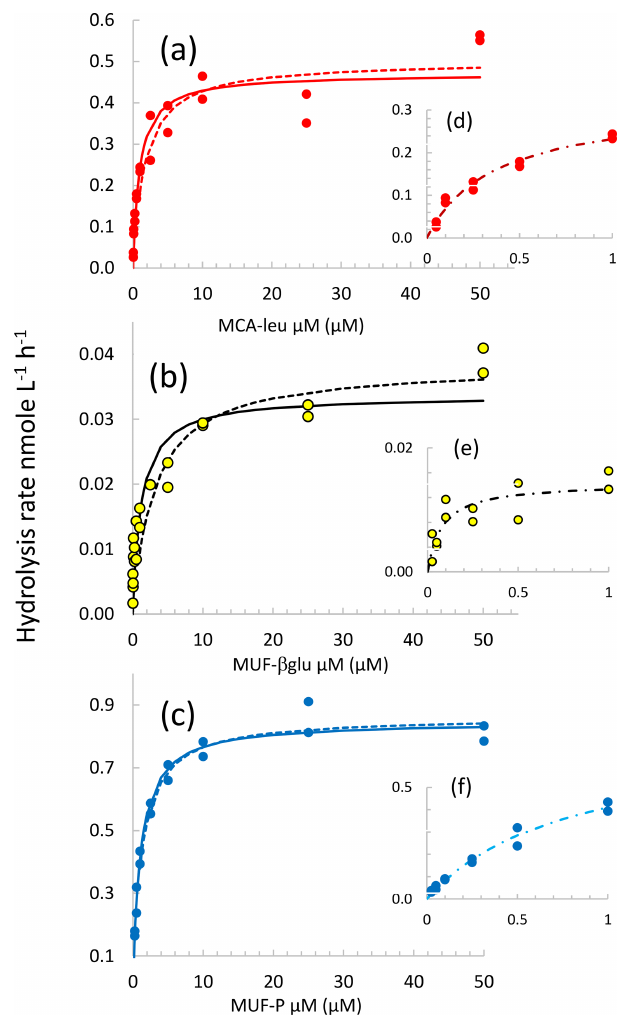
Figure 3. Michaelis–Menten kinetics for the DCM layer at station FAST. (a, b, c) Data are shown by the dots, continuous lines cor- respond to the nonlinear regression of the global model (concentra- tion set 0.025 to 50µM), and dotted lines correspond to the nonlin- ear regression of model 50. (d, e, f) Michaelis–Menten kinetics for model 1 (concentration set